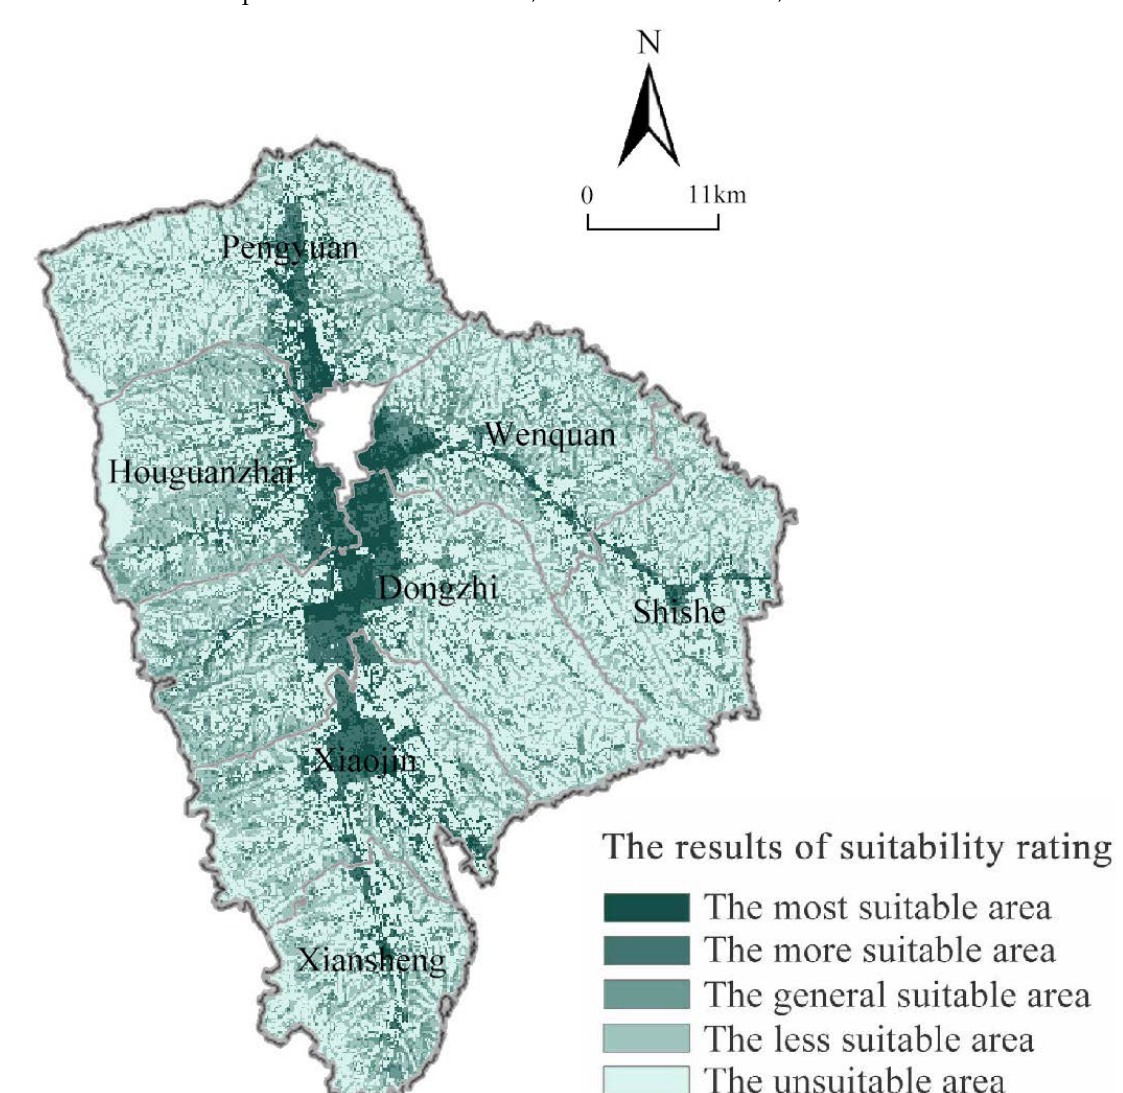
Figure 3. The suitability grade of township construction land in Xifeng. Table 2. Xifeng’s township construction land suitability of hierarchies and area ratio.